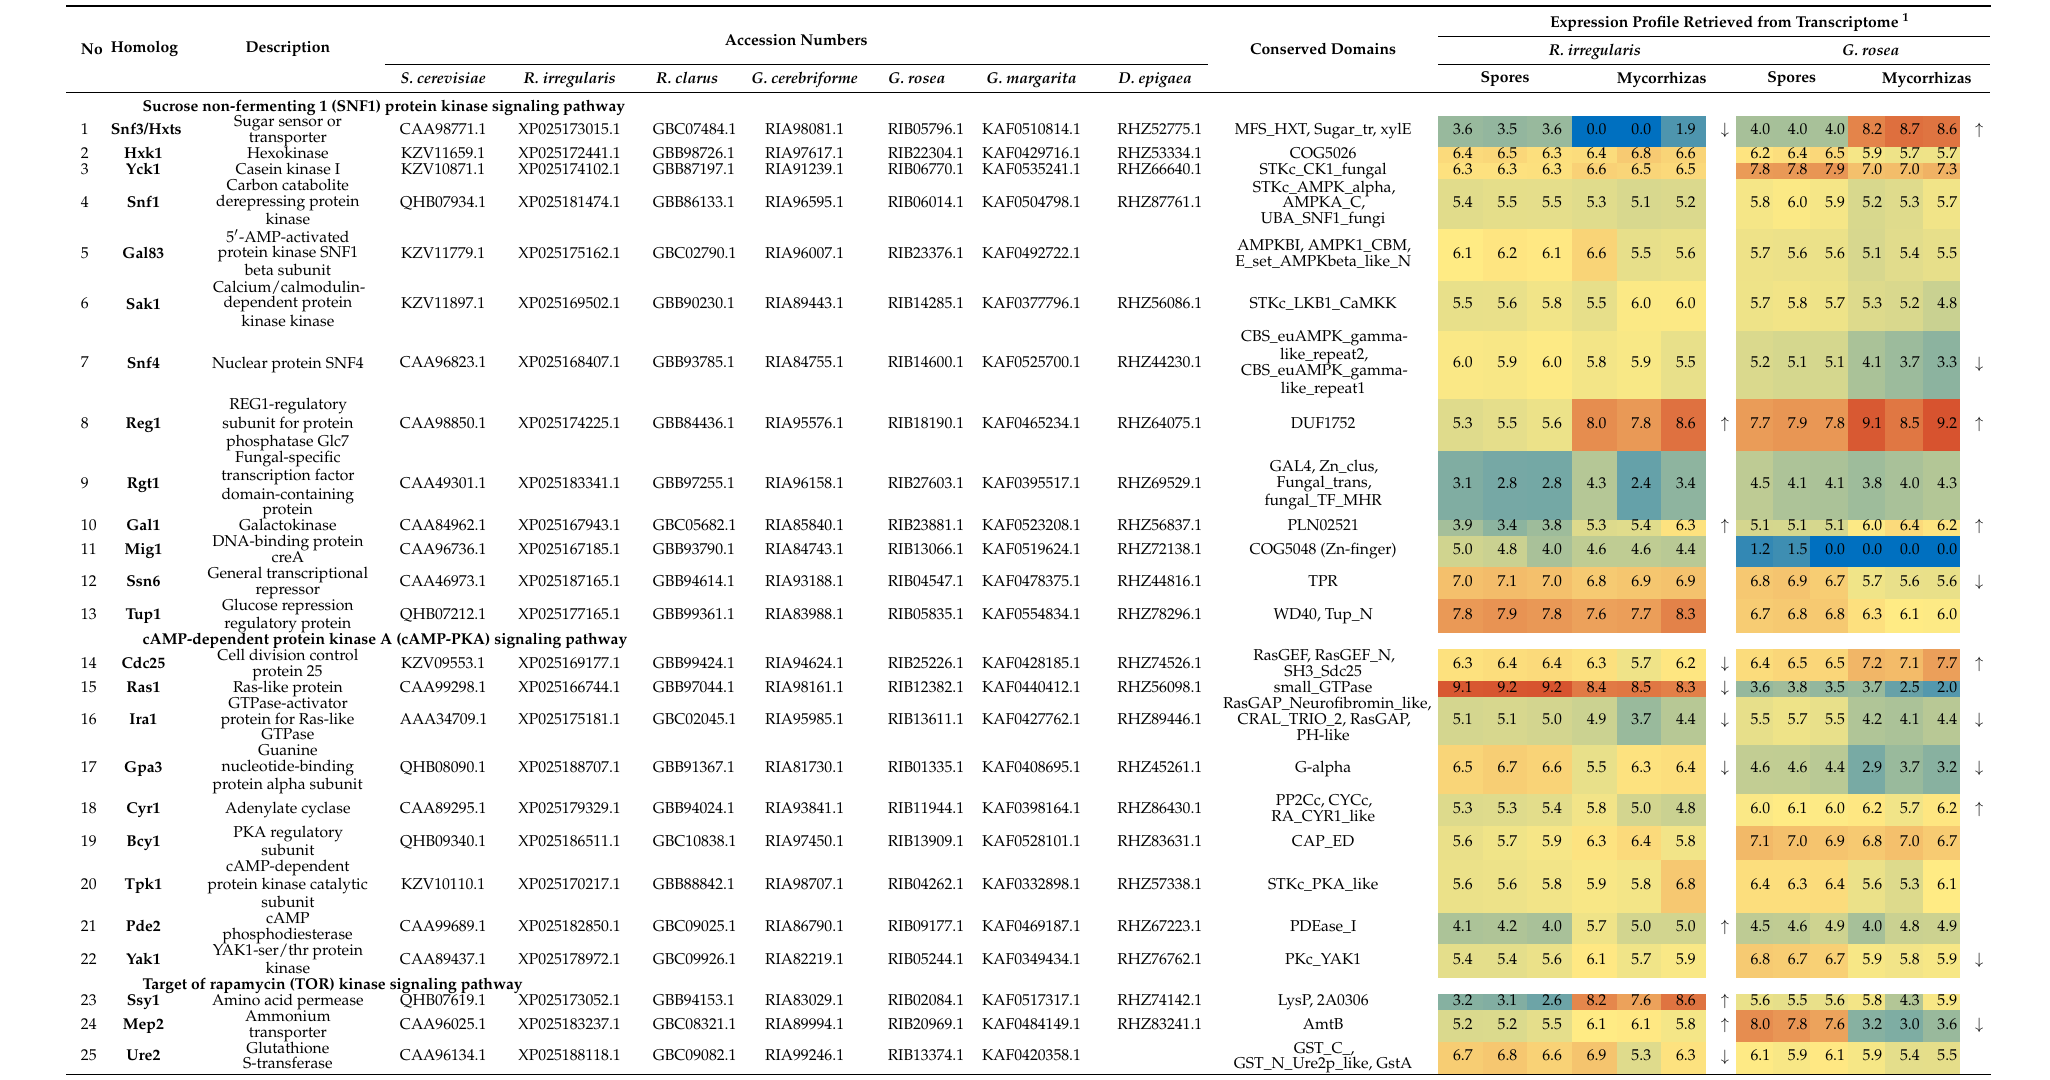
Table 2. The conserved components of nutrient signaling pathways in AM fungi and their transcript patterns in AM fungal